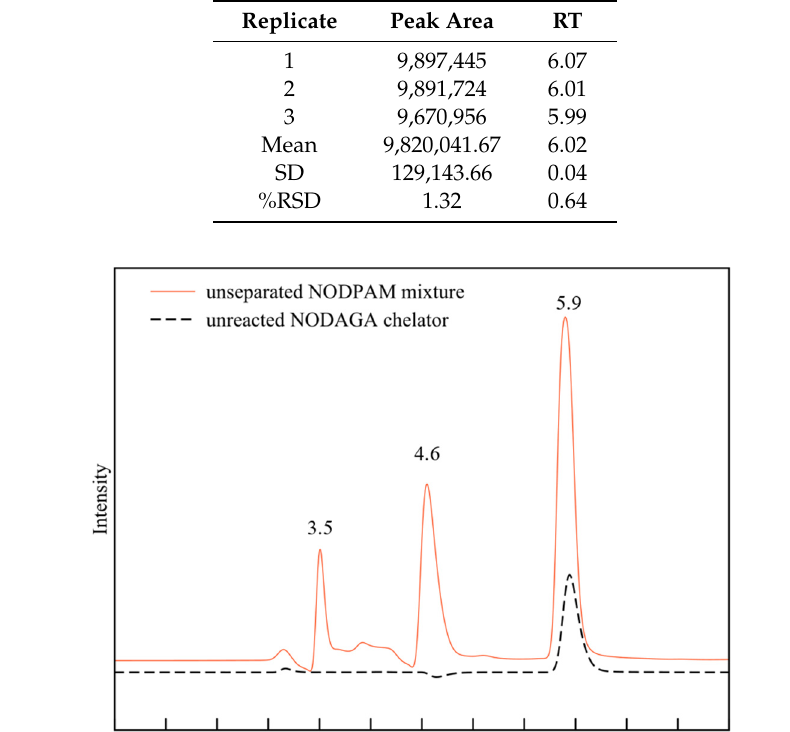
Table 5. The precision of the unreacted NODAGA chelator 1 mg / mL based on the peak area and retention time.